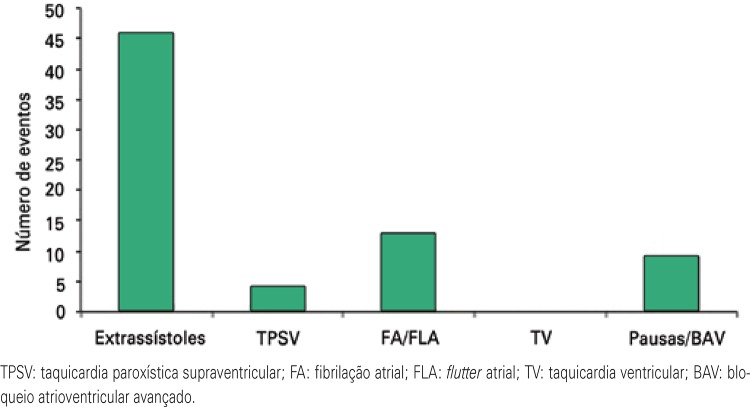
Tipo de arritmias detectadas pelo monitor de eventos